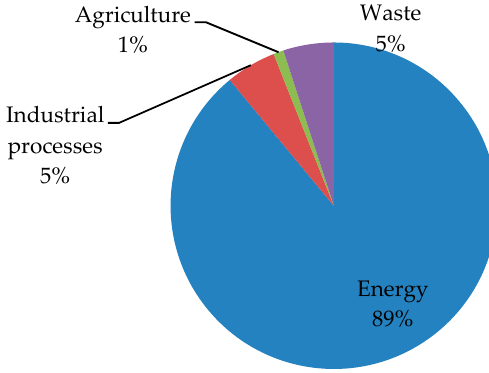
Figure 5. Carbon dioxide emission for Saudi Arabia: years 1970–2016. (Source: CO 2 time series 1990–2015 per region/country, Netherlands Environmental Assessment Agency).